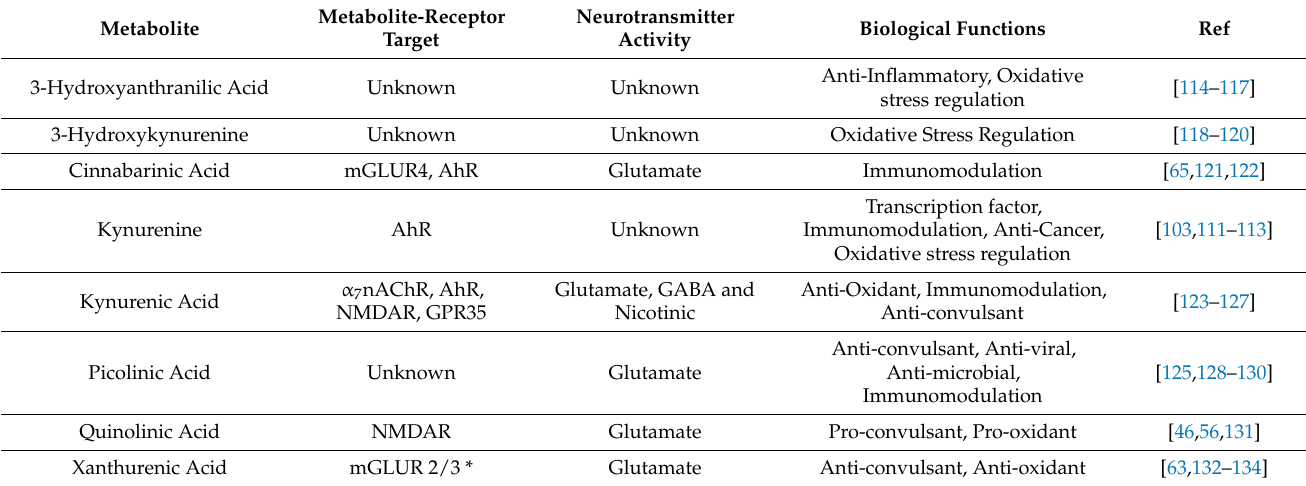
Table 1. Summary of individual KP metabolites with known receptor targets, influence on neurotransmitter systems and other key biological functions within the context of CNS health and disease (*